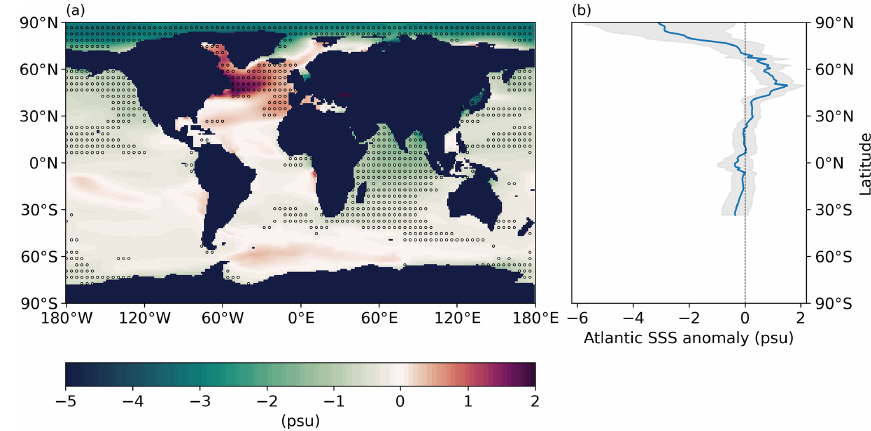
Figure 5. (a) Multi-model mean mPWP–PI difference in sea surface salinity (SSS). Stippling indicates that 12 or more models agree on the sign of the difference. (b) Atlantic zonal-mean SSS anomaly, excluding the Mediterranean Sea and North Sea. The shading indicates 1 standard deviation from the MMM by individual models.